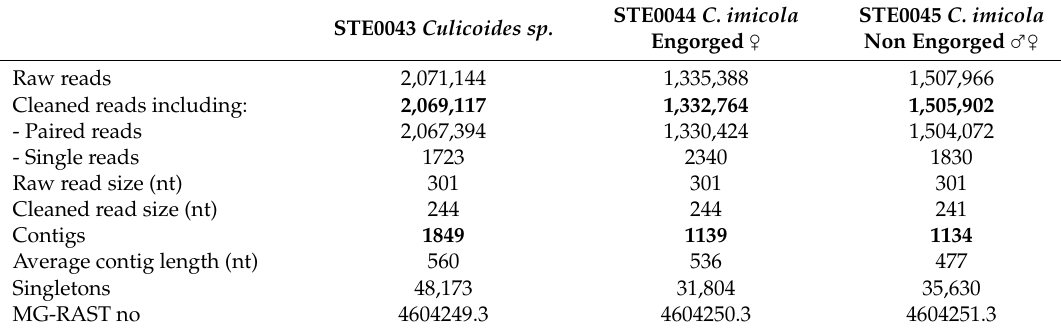
Table 1. Virome dataset